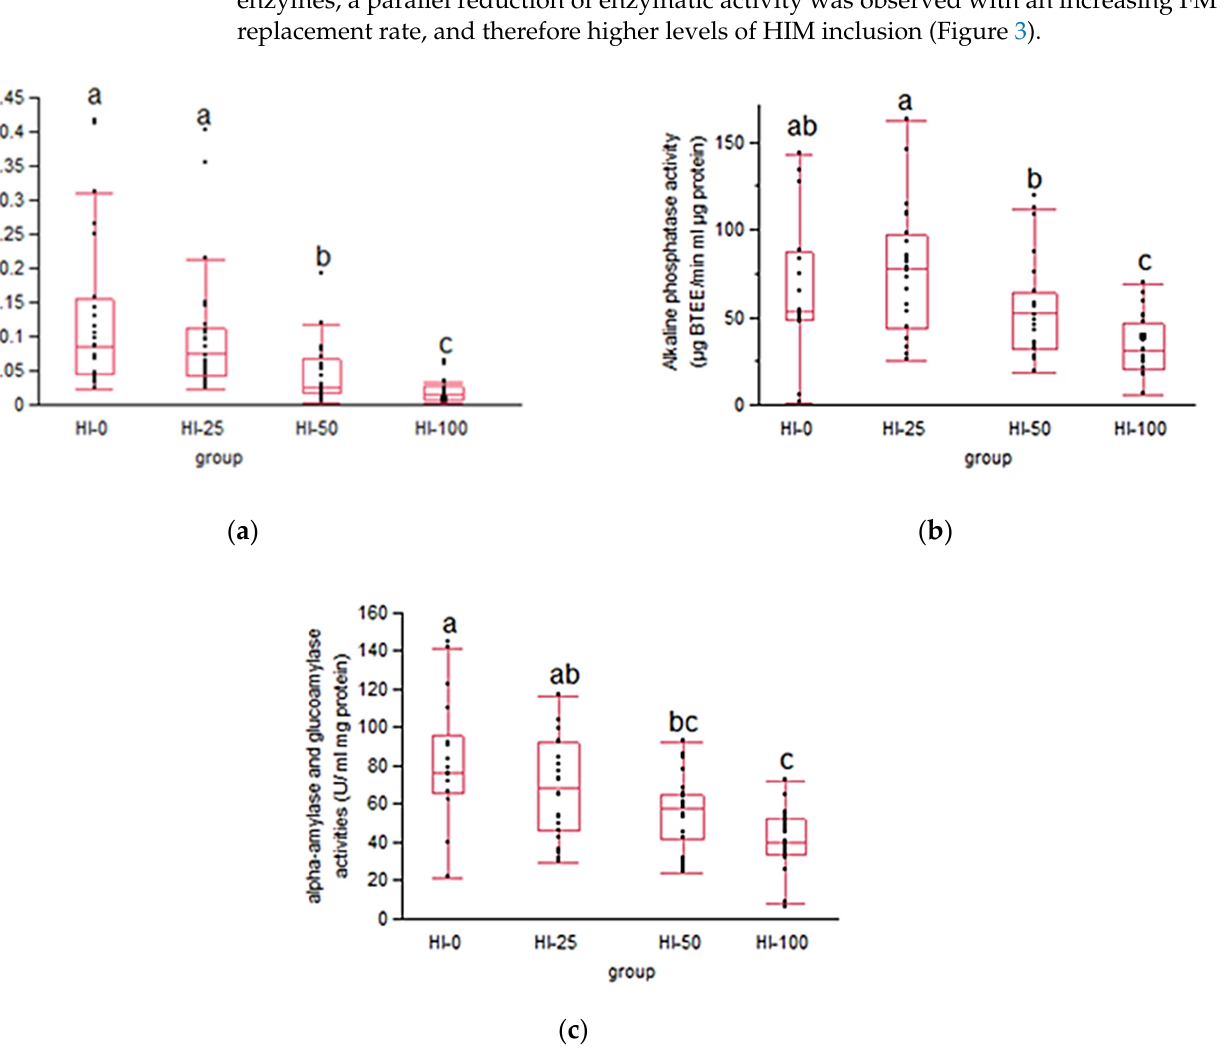
Figure 3. Enzymatic activities of the midgut among the experimental groups. ( a ) Trypsin activity; ( b ) alkaline phosphatase activity; ( c ) α -amylase-glucoamylase activity. Values with different lowercase letters are significantly different ( p < 0.0001).